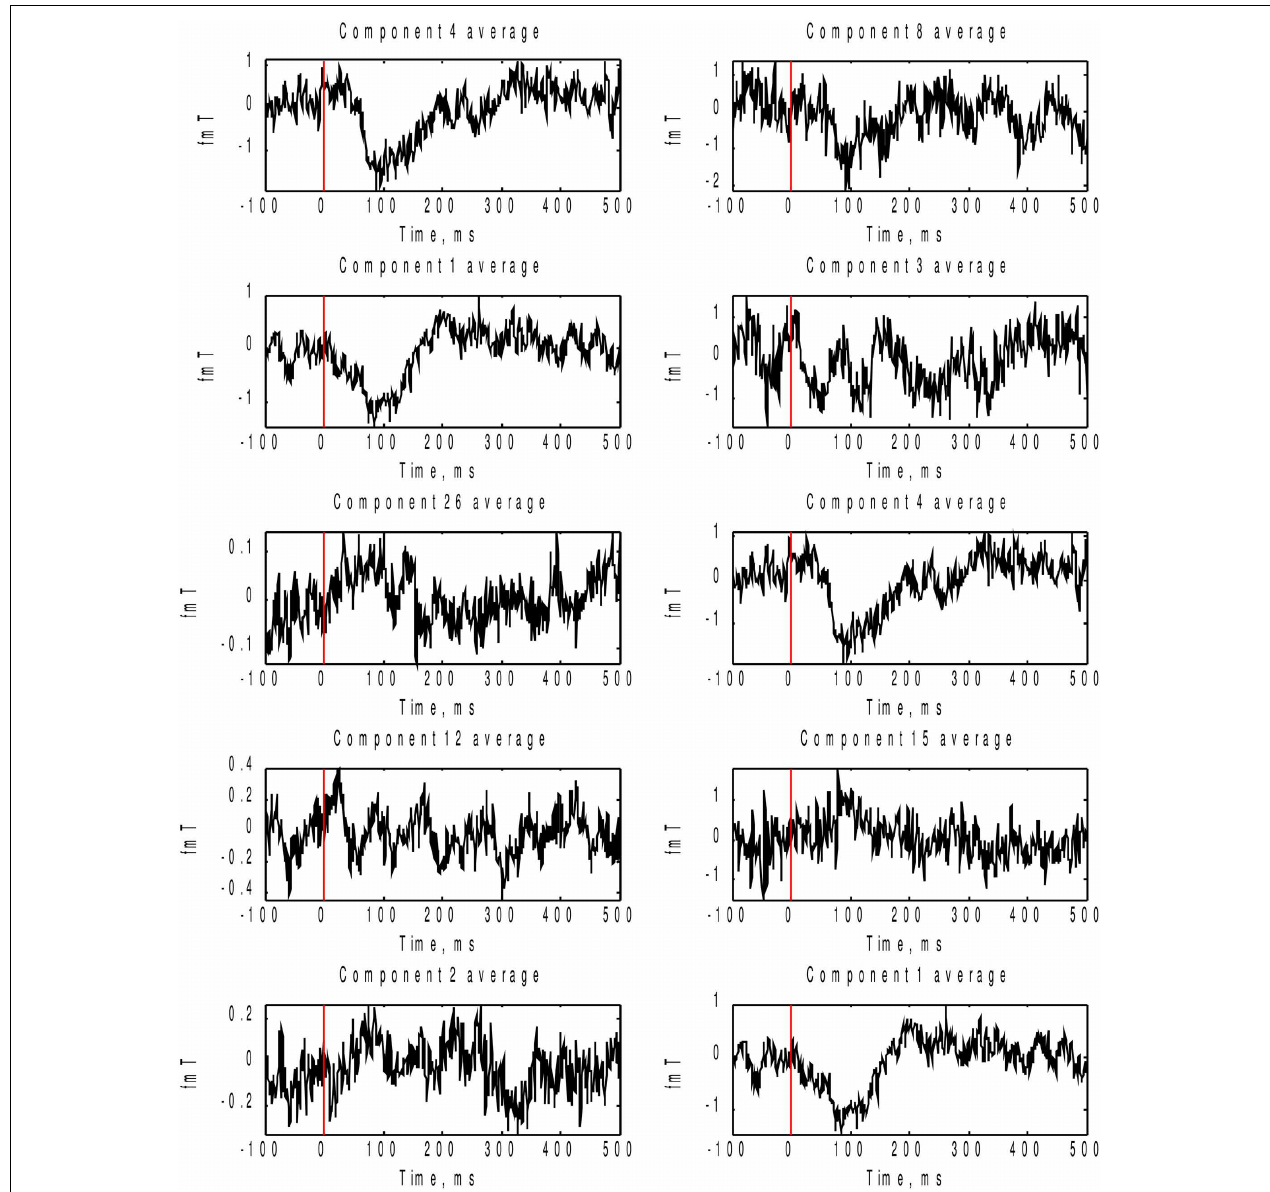
FIGURE 10 | In order to check which of the two methods provide the right answer we performed stimulus-locked averaging of the first five components in the order prescribed by sorting of MI and AP spectra (Figure 9). Left panel corresponds to MI prescribed components and the right panel - to AP. As it can be seen the first two components (4 and 1) emphasized by the MI spectrum ( Figure 9A )